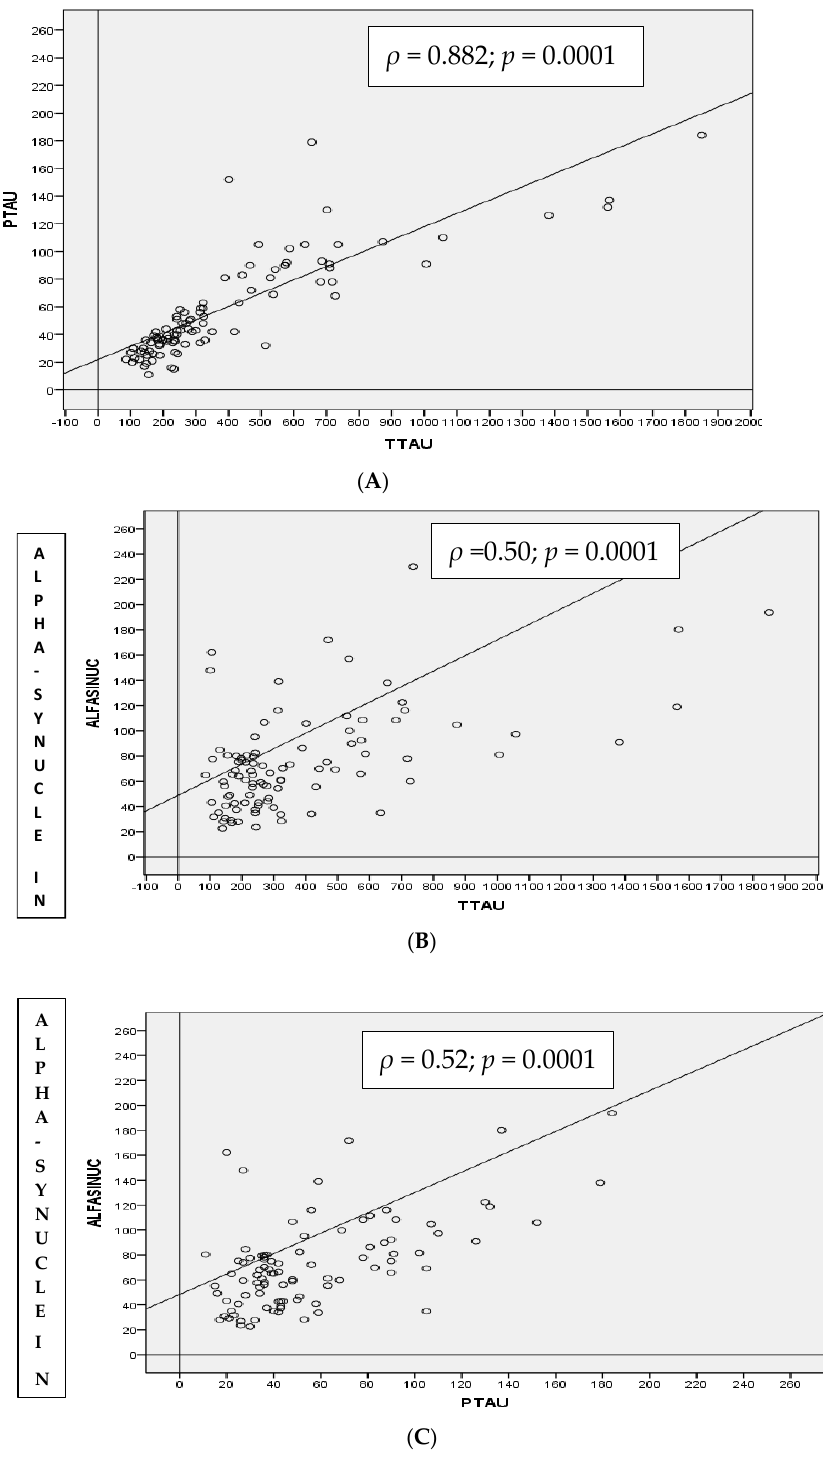
Figure 1. Spearman correlation ( ρ ) in the whole cohort between CSF T-tau and p-tau 181p ( A ), α-synuclein and T-tau ( B ) and α-synuclein and p-tau 181p ( C ) proteins in total population. 3.3. MCI-AD Group In this group, there were statistically significant correlations between α-syn levels with T-tau ( ρ = 0.418, p -value < 0.01) (Figure 2B), particularly with p-tau 181p ( ρ = 0.571, p - value < 0.001) (Figure 2C). T-tau and p-tau 181p CSF levels were positively correlated ( ρ = 0.511, p -value < 0.003) (Figure 2A) but no other correlations were found between the “core” biomarkers with either of the CSF α-syn levels.